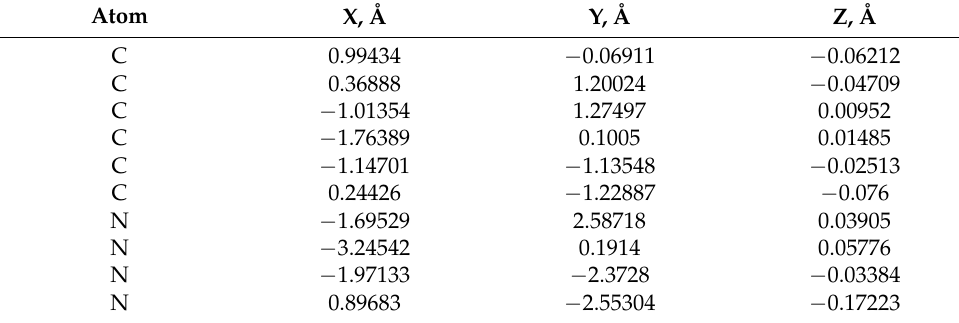
Table A2. Convergent geometries of